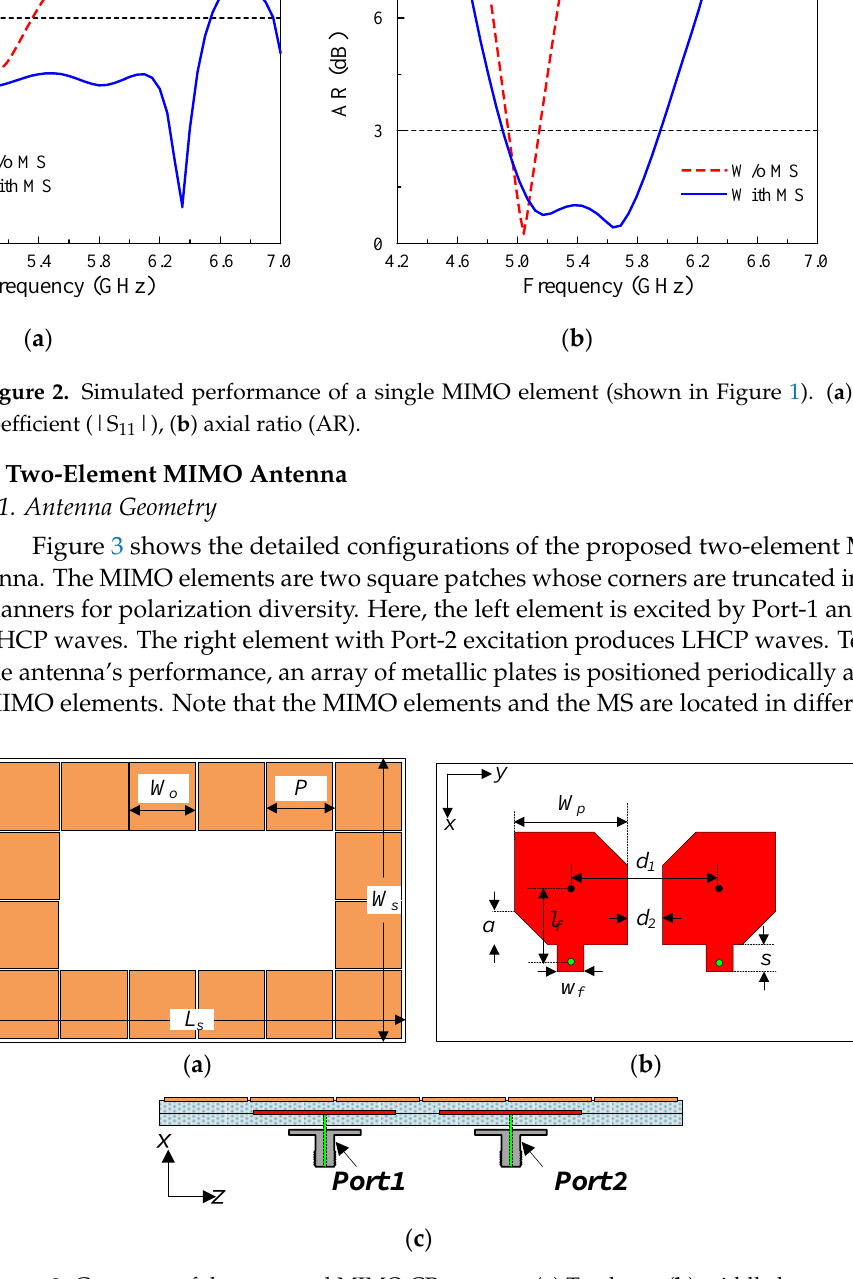
Figure 3. Geometry of the proposed MIMO CP antenna. ( a ) Top layer, ( b ) middle layer, and ( c ) cross-section view. The final parameters are L s = 49.2 mm, W s = 32.8 mm, H s = 1.52 mm, W p = 13.3 mm, a = 4.2 mm, l f = 9.3 mm, w f = 3 mm, s = 3.2 mm, P = 8.2 mm, W = 8 mm, d 1 = 18 mm, d 2 = 4.7 mm.